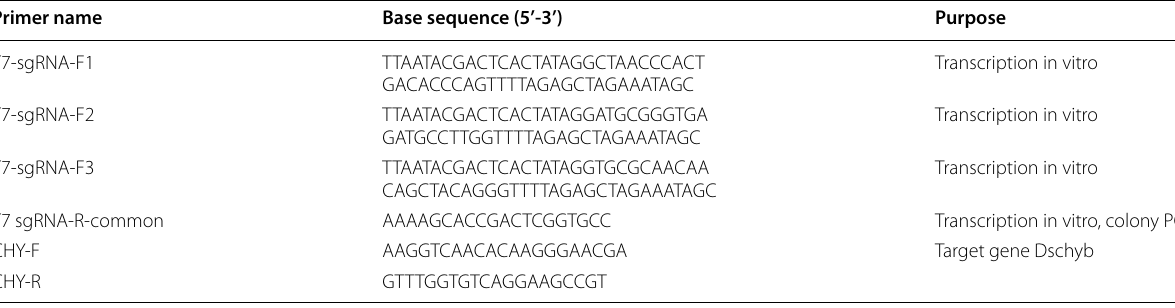
Table 2 The primers used for sgRNA transcription in vitro and target